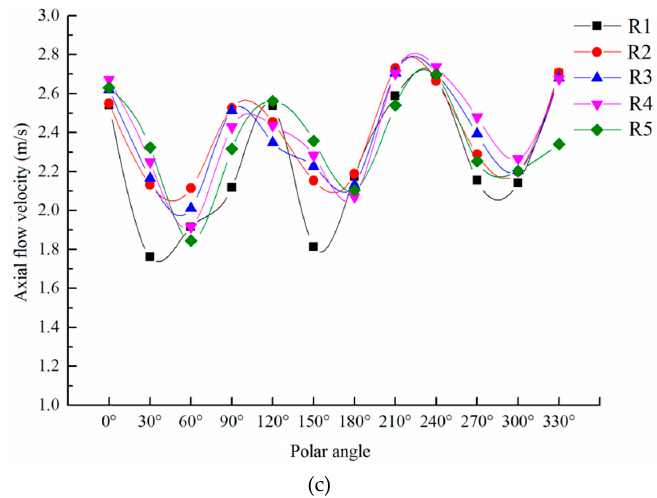
Figure 13. Axial velocity of the same measuring ring: ( a ) rear section; ( b ) middle section; and ( c ) front section.